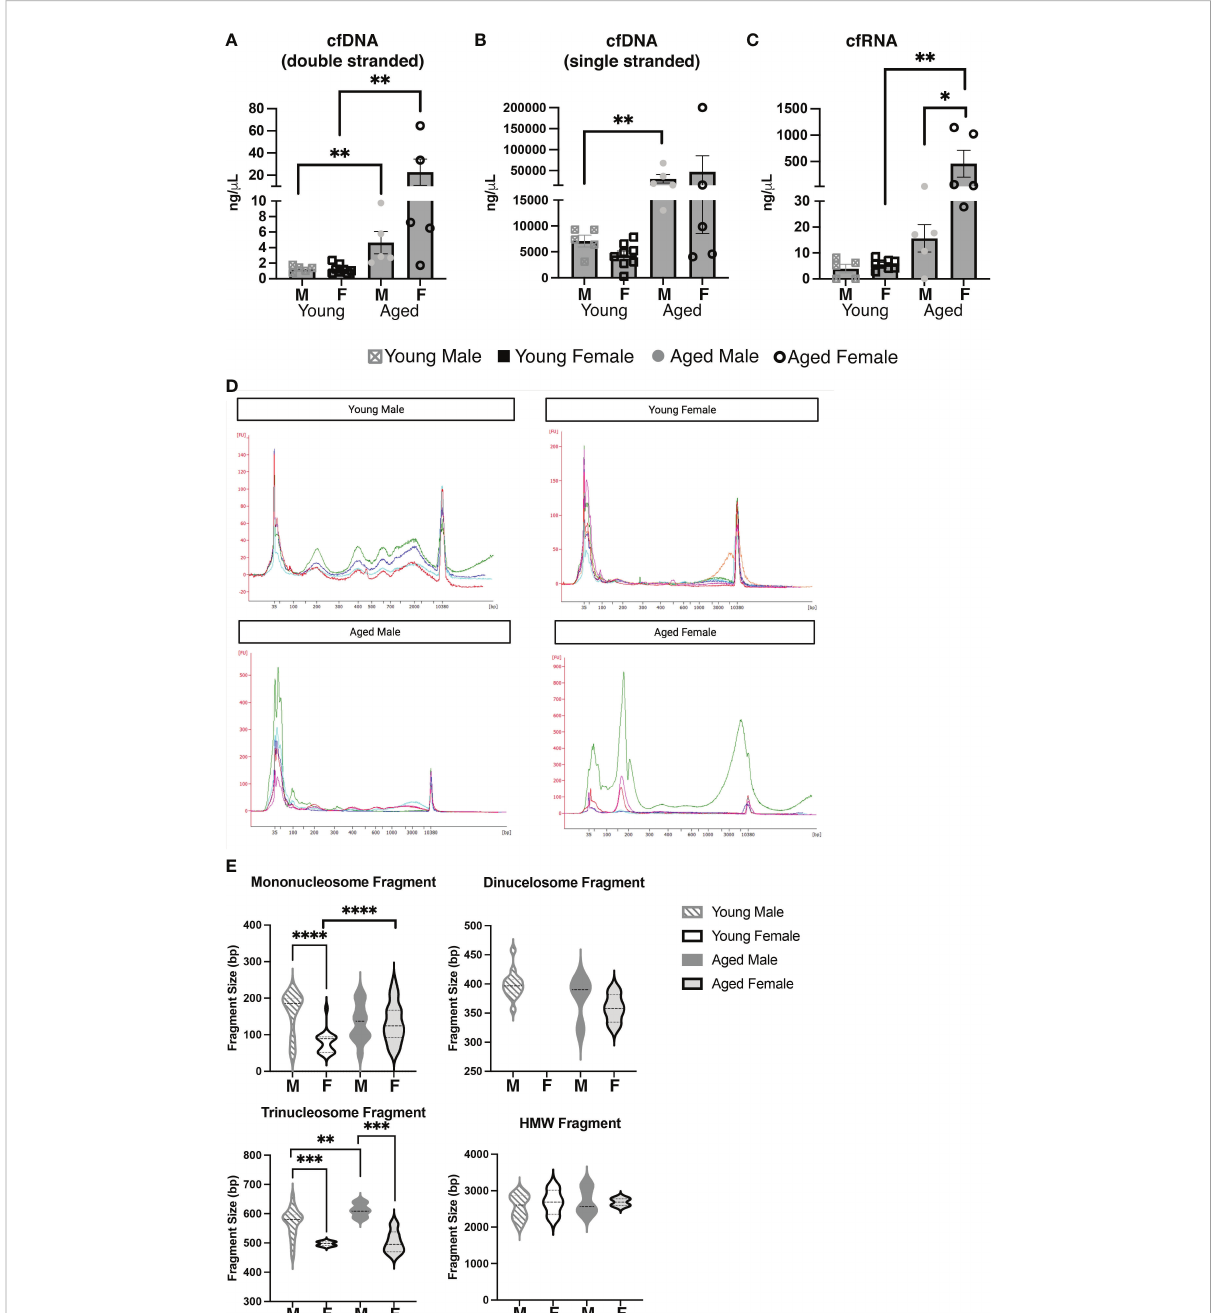
FIGURE 8 Aging and biological sex in fl uences the levels and composition of serum cell-free nucleic acids. Serum was obtained from young (3-month-old) or aged (18-25-month-old) male and female BALB/c-ByJ mice (young male mice n=10, aged male mice n=10, young female mice n=7, aged female mice n=9). Cell-free (cf) nucleic acids were isolated from 200ul of each individual serum sample. (A) Double-stranded cfDNA, (B) single- stranded cfDNA, and (C) cfRNA were quanti fi ed using the Qubit 4. (D) cfDNA was measured on the Agilent 2100 Bioanalyzer using the HS DNA assay, and individual electropherograms for each sample were combined for each group (young and old males and females). (E) cfDNA fragment sizes for each of the three major cfDNA peaks (50 – 250, 250 – 450, 450 – 650) and the HMWcfDNA (~2300bp) from each trace were mapped with violin plots. Statistics used: Mann-Whitney test and Welch ’ s t-test (violin plots). Asterisks for p values: *p<0.05, **p<0.01, ***p<0.001,